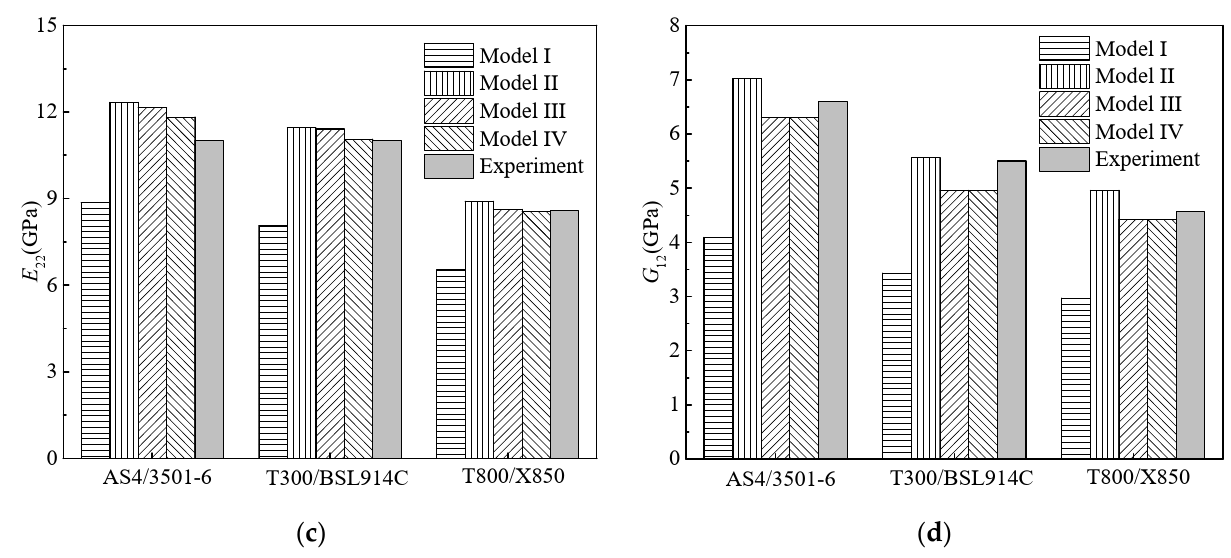
Figure 4. Comparisons between the calculated elastic properties and the experimental values of the three composites. ( a ) E 11 ; ( b ) v 12 ; ( c ) E 22 ; ( d ) G 12 . Furthermore, the relative errors, ε , obtained by comparing the theoretical values with the experimental values are depicted in Figure 5a–c. Since the equations for E 11 and v 12 are the same in all four models, their theoretical values are equal. Additionally, the errors of E 11 and v 12 are very small, except that the E 11 of the T800/X850 composite has an error greater than − 10%. The E 22 obtained from Model I is remarkably smaller than the test values, with errors up to − 27%, while those obtained from Models II to IV are larger than the experimental values, with decreasing errors in sequence, which are below 12%. The G 12 obtained from Model I is also far less than the test values, with errors higher than − 35%; however, those obtained from Model II are larger than the test values, with errors below 8.5%, and those acquired from Models III to IV are smaller than the test values, with errors below − 10%. To conclude, for the three composites, the errors of Model I are unacceptably large, and the errors of Models II–IV remain approximately below 10%. This is in accordance with the findings in [19–23,34,35,42], which demonstrated that Model I shows large differences from the experimental or numerical results, whereas Models II–IV differ slightly from the experimental or numerical results.